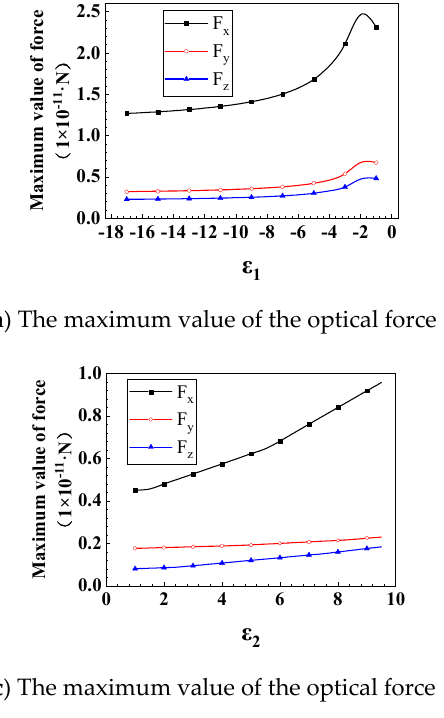
Figure 11. The maximum and minimum values of optical force varies with ε m . Panels ( a – d ) describe the effects of the real and imaginary parts of the nanorod’s dielectric constant on the maximum and minimum values of optical force, respectively .